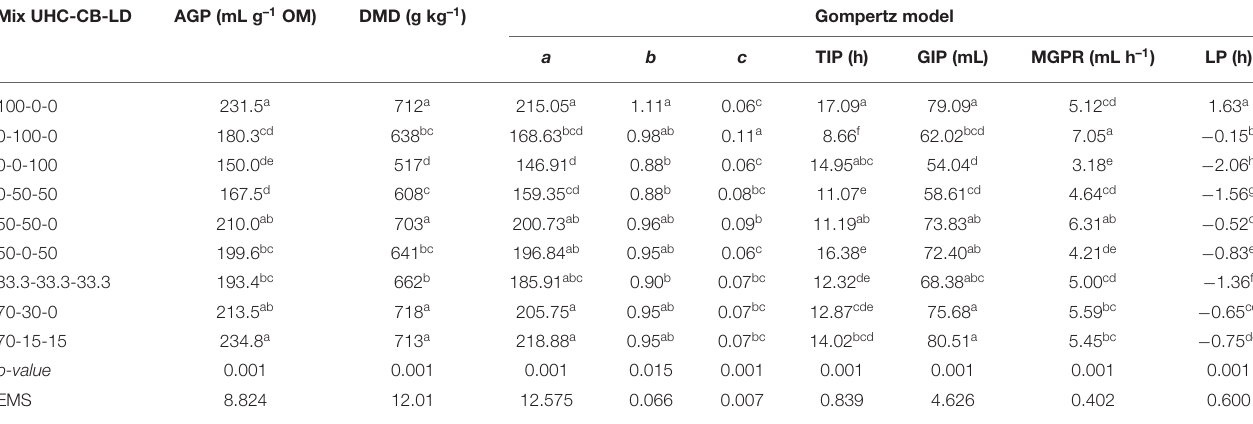
TABLE 3 | Accumulated gas production (AGP; mL g − 1 OM), dry matter degradability (DMD), and profiles of the adjustment made using the Gompertz model for UHC, CB, LD, and their